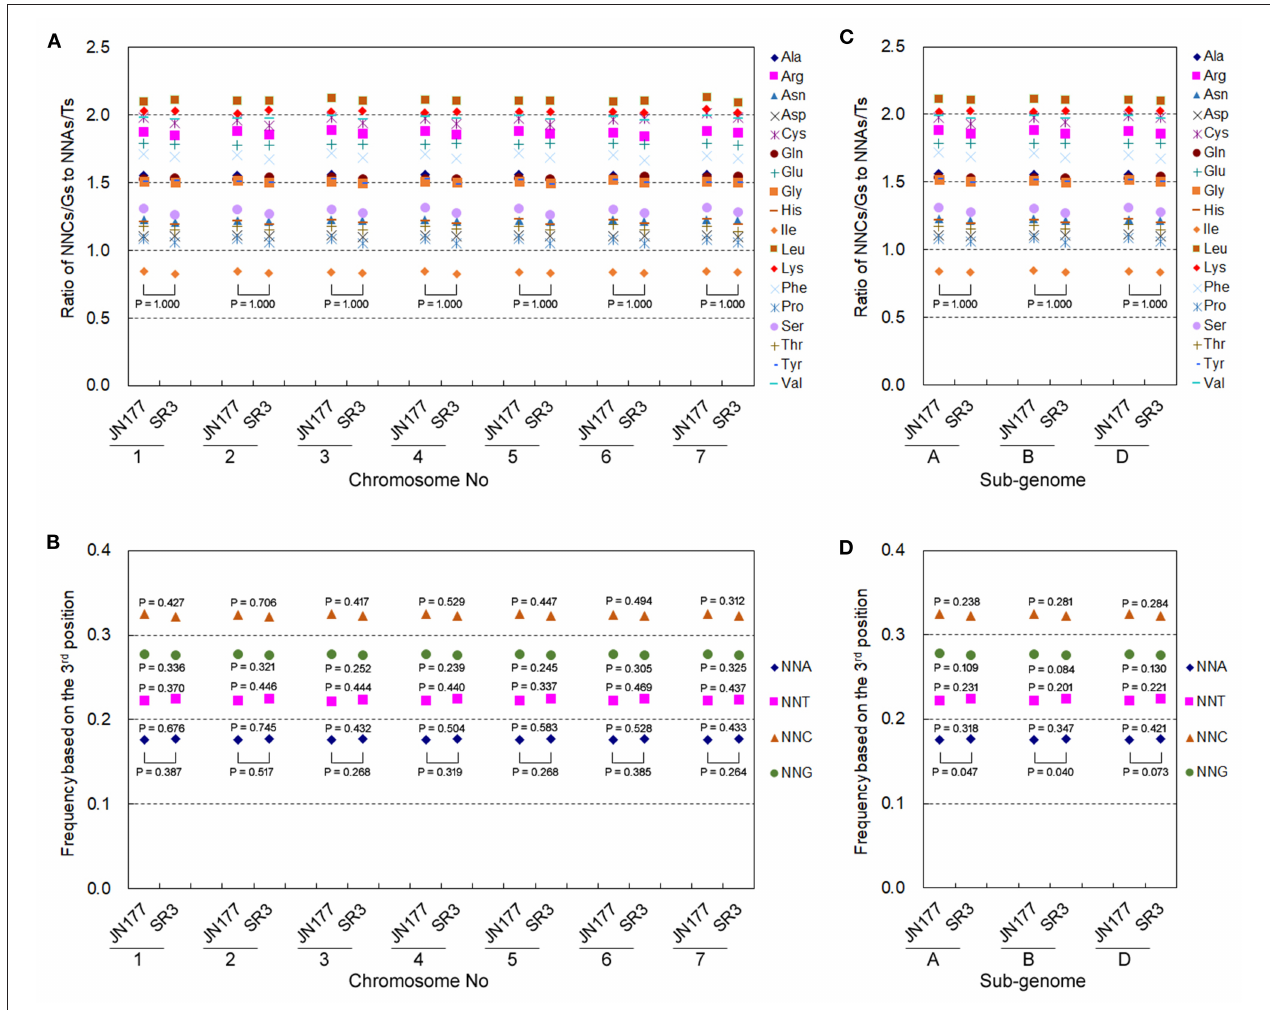
FIGURE 5 | The patterns of SCUB shift based on allelic chromosomes and sub-genomes. (A,C) The ratios of the frequencies of NNC/NNG SCs to NNA/NNT SCs in seven groups of allelic chromosomes (A) and three sub-genomes (C) . NNCs/Gs: SCs with C or G as their final bases; NNAs/Ts: SCs with A or T as their final base. (B,D) The total frequency of NNA, NNT, NNC, and NNG codons in seven groups of allelic chromosomes (B) and three sub-genomes (D) . The total frequency was calculated as the ratio between the amounts number of all SCs ending with A, T, C, or G and the amount of all SCs. The statistical comparison was conducted with chi square ( χ 2 ) test of fourfold cross-table